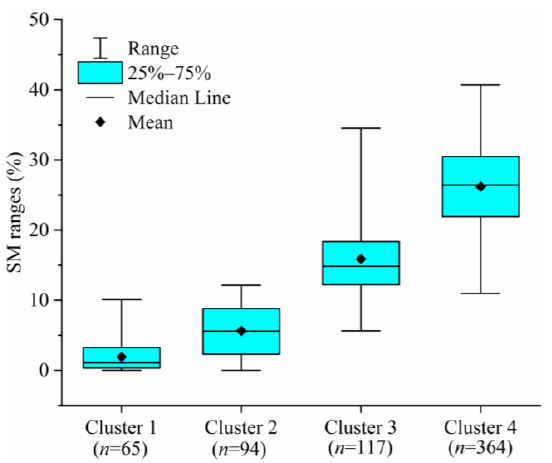
Figure 8. Box-plots of SM in four clusters using SM–based cluster method (in the calibration dataset).